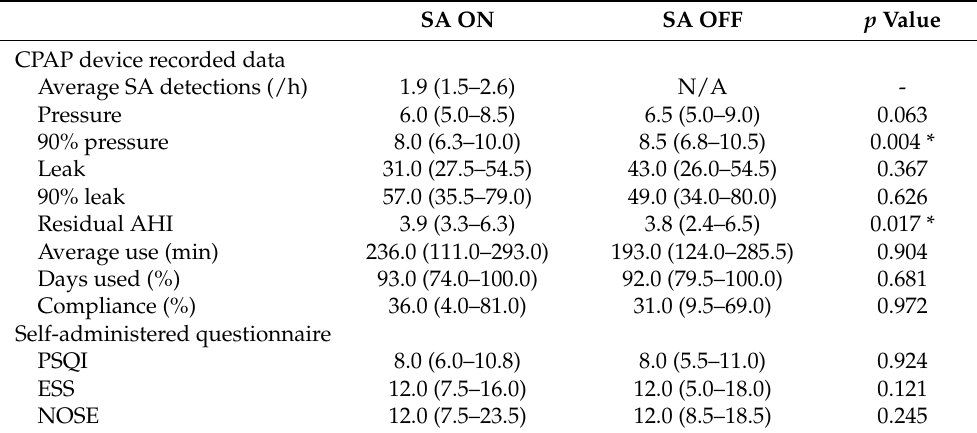
Table 2. Comparison of SensAwake TM ON and OFF during CPAP therapy. ( n = 25). SA ON